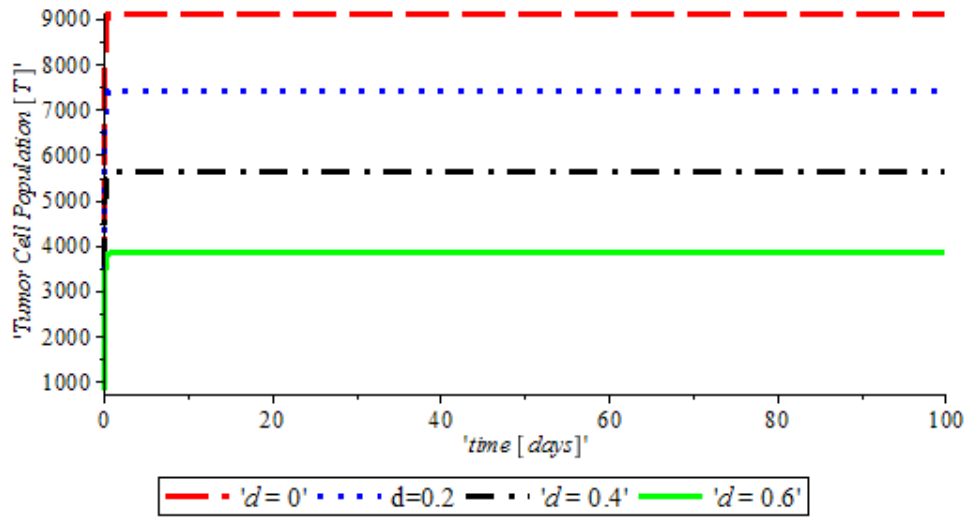
Figure 3. The variation of proportion of Tumor cell population for different value of ‘d’ with other parameters fixed